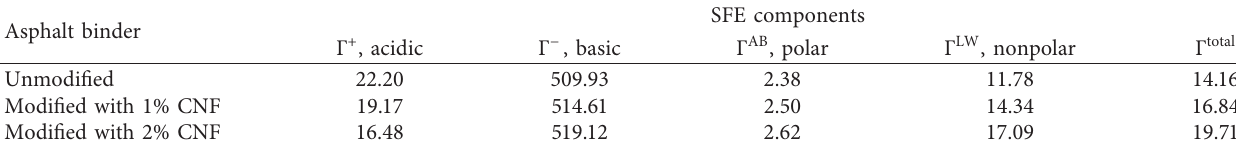
Table 5: The SFE components of the unmodified and modified asphalt binders (mJ/m 2 ).